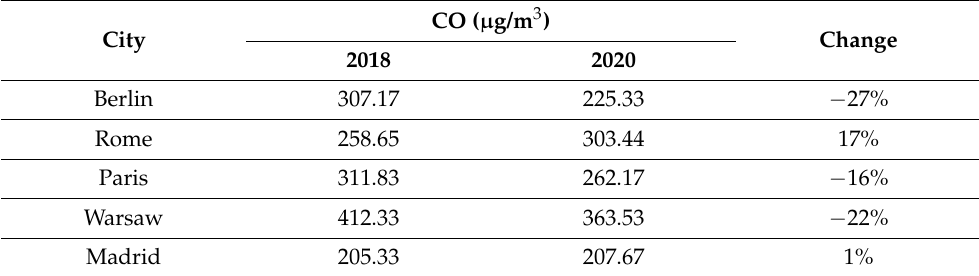
Table 4. The average change in the level of CO concentration on 20 March to 15 April 2018, and 2020 in selected European